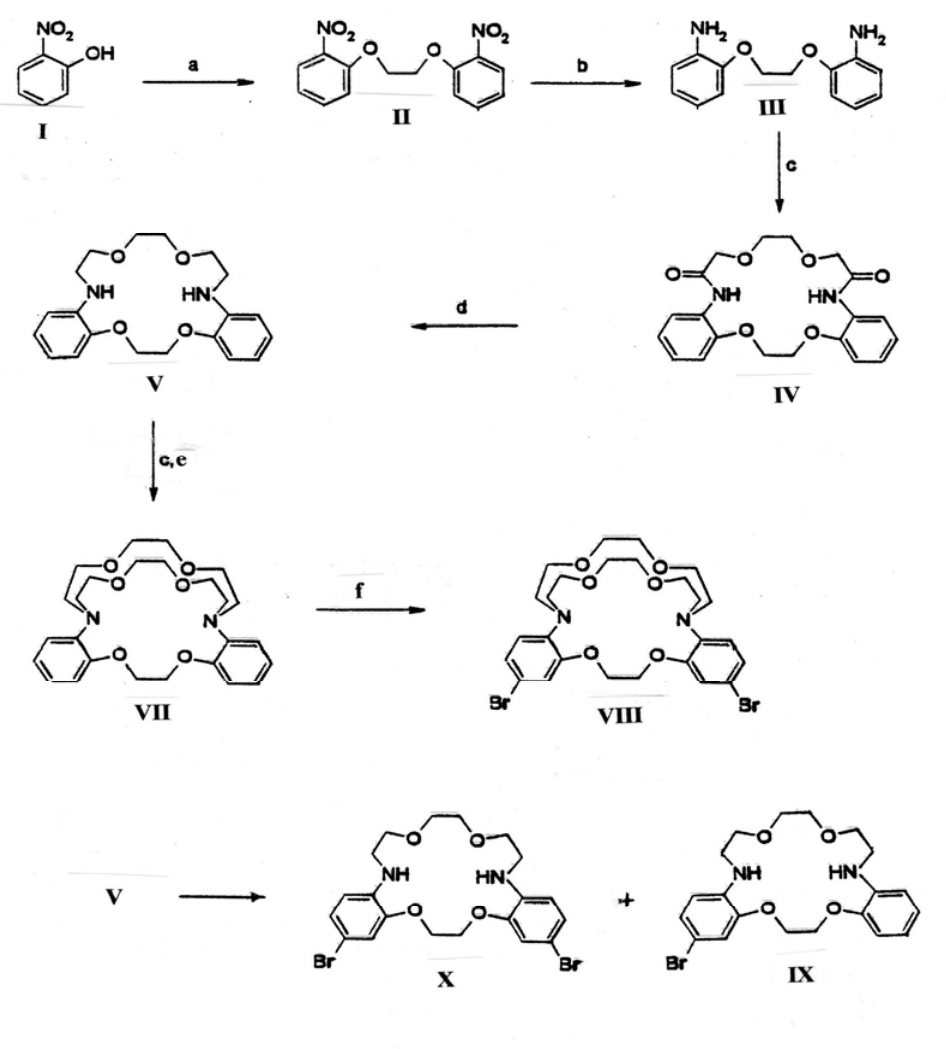
Figure 1. 1 H-NMR (300 MHz, CDCl